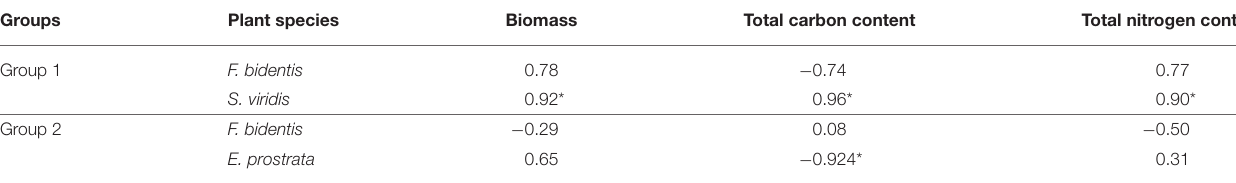
TABLE 2 | The correlation of colonization rate with biomass and C and N content. Groups